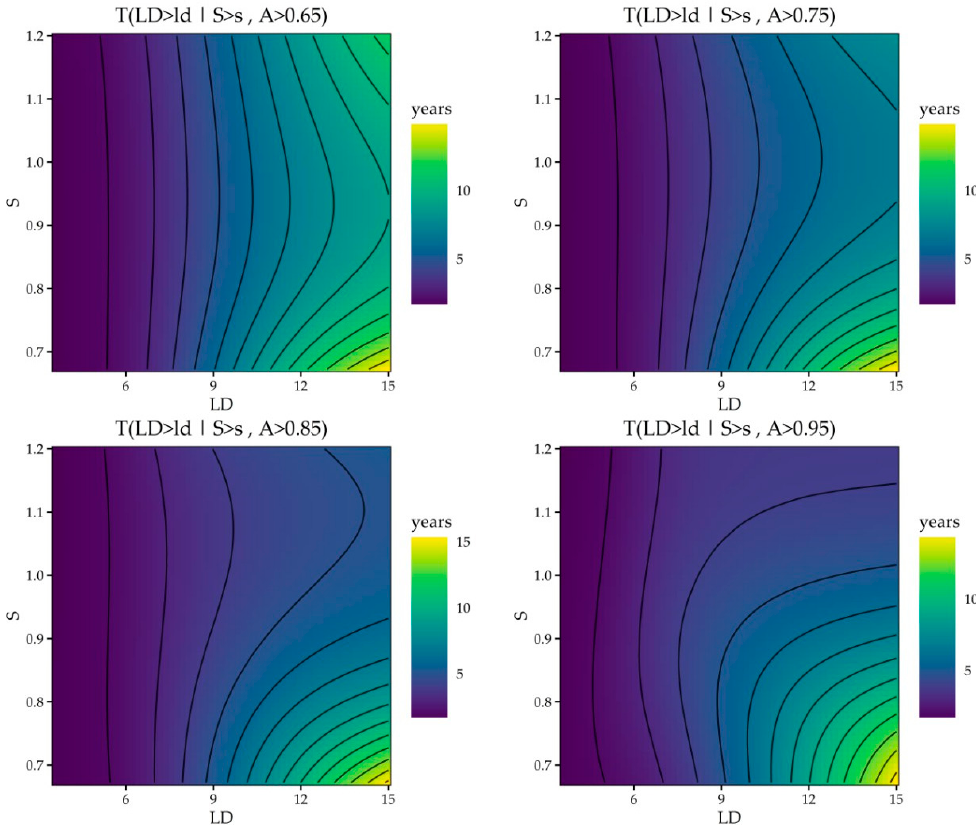
Figure 5. T of trivariate drought characteristics (for the cases of A(cid:3365) greater than 75, 85, and 95 percent), where LD is given in months and for brevity S(cid:3364) and A(cid:3365) are shown as S and A , respectively.